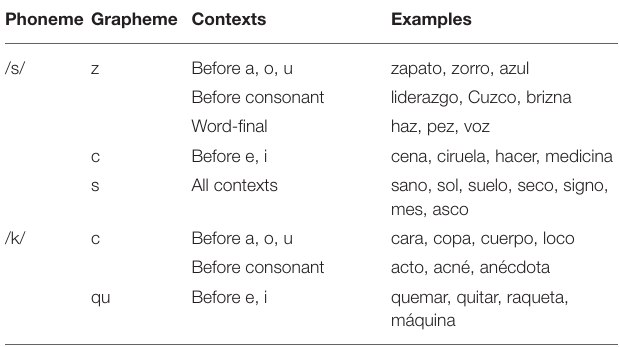
TABLE 1 | /s/ and /k/ graphemic correspondences in Latin American Spanish. Phoneme Grapheme Contexts